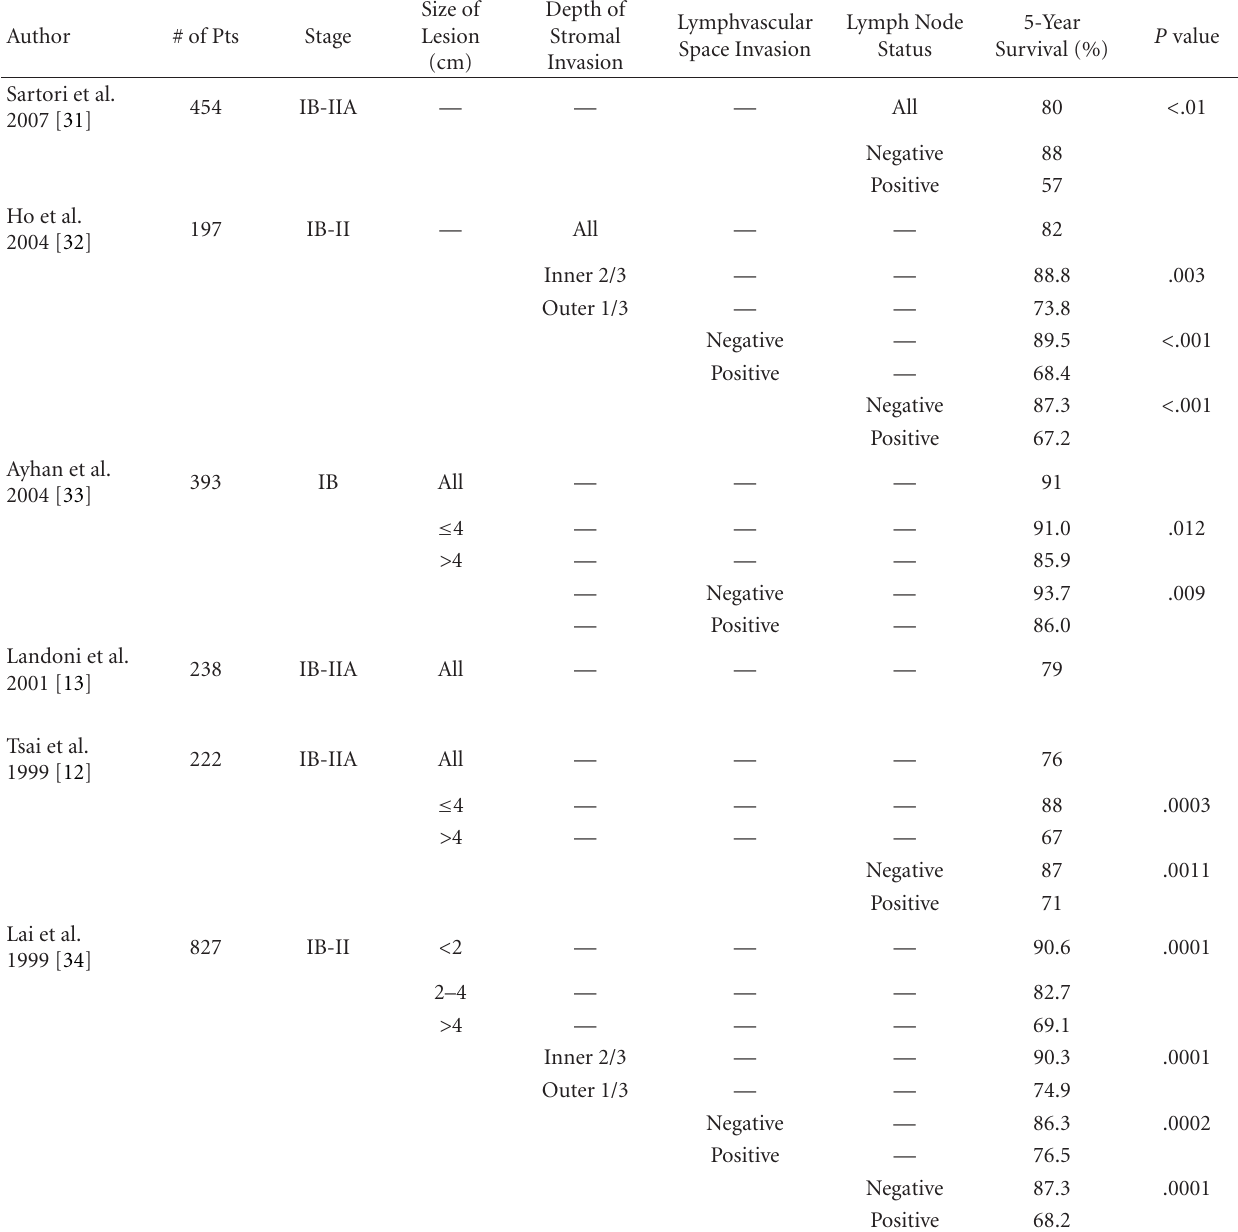
Table 2: Five-year survival following radical hysterectomy for cervical